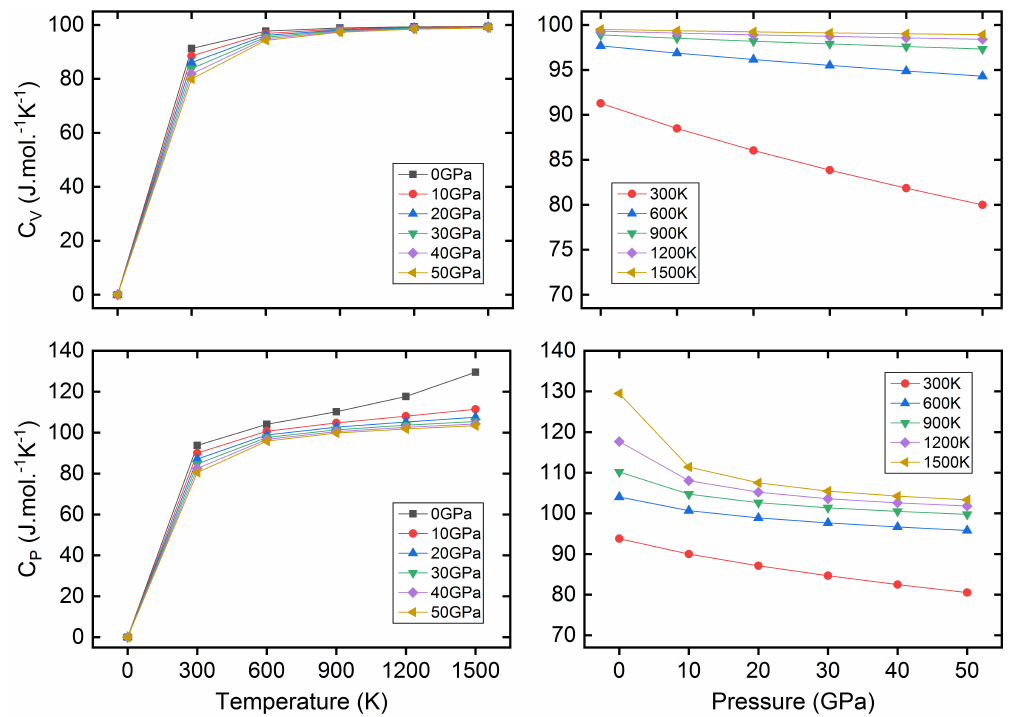
Figure 11. The variation of heat capacity C V and C P with temperature ( left ) and pressure ( right ) for Ti 2